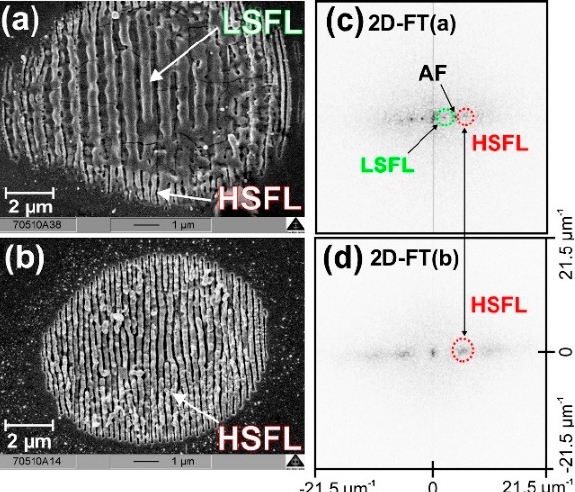
Figure 2. ( a ) SEM micrographs of ZnO after irradiation with 10 laser pulses at a fluence of 0.62 J/cm 2 ; ( b ) SEM micrographs of ZnO after irradiation with 50 laser pulses at a fluence of 0.48 J/cm 2 ; ( c ) 2D − FFT of the SEM micrograph ( a ); ( d ) 2D − FFT of the SEM micrograph ( b ); AF indicates an artifact of the 2D-FFT process of 2c. Reproduced with permission from Ref. [37]. Copyright 2006 American Institute of